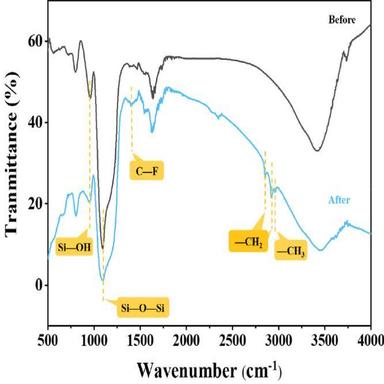
FTIR spectra of FDB/nano-SiO2 mixture before and after modification.